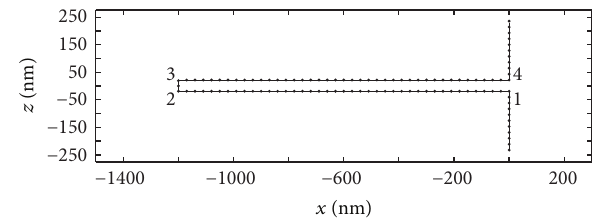
Figure 10: Current distributions along nanocircuit at frequencies 𝐹 = 215 and 348 THz for cases with voltage reflection coefficient = 10 , ℎ | = 0.77 and 0.32, respectively. Parameters of MoM simulation |Γ 𝑉 are ℎ = 210 nm, 𝐿 = 1200 nm, 𝑎 𝐿 = 𝑎 ℎ = 10 nm, 𝑑 = 40 nm, = 10 , 𝑁 = 40 , Δ𝐿 = 30 nm, Δ𝐿 = 21 nm, and 𝑁 = 102 𝑁 ℎ 𝐿 𝐿 ℎ